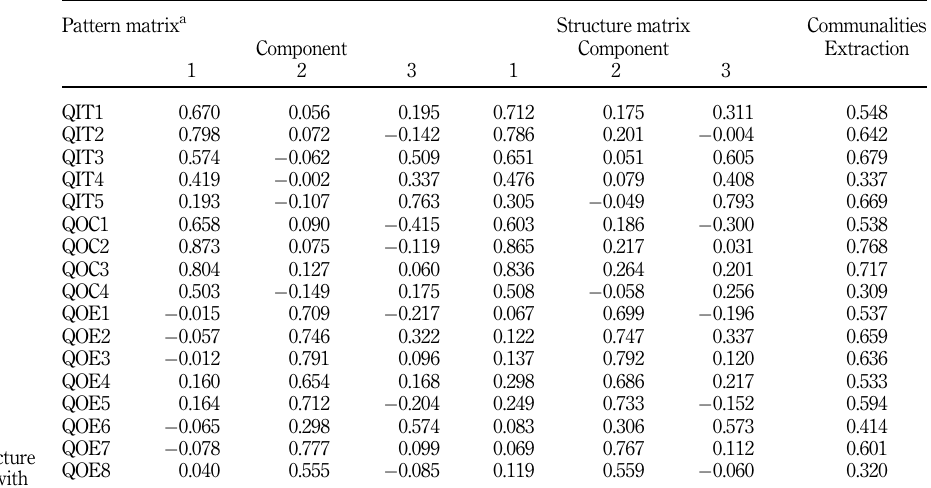
Table A1. Pattern and structure matrix for PCA with Oblimin rotation of three factor